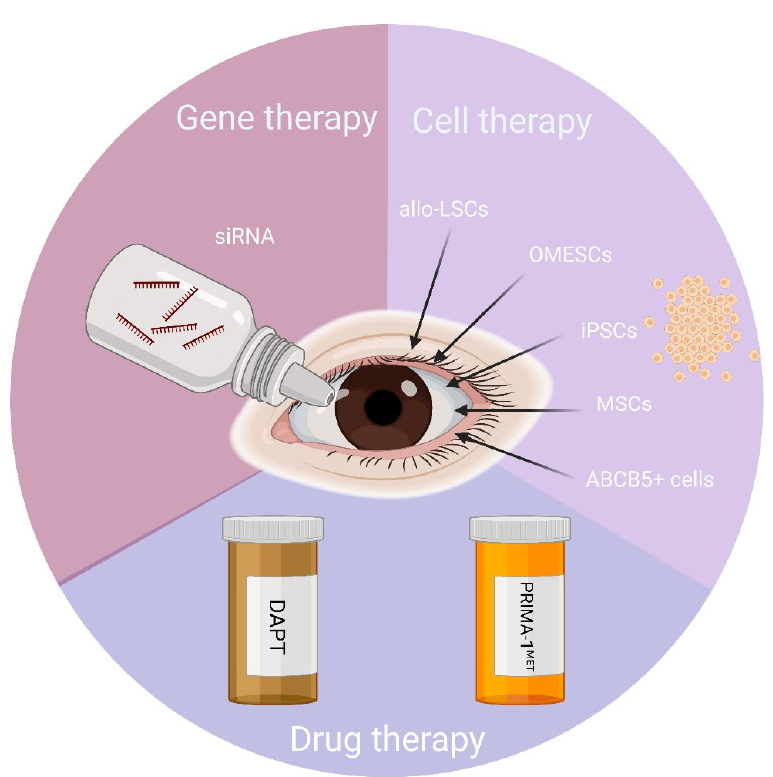
Figure 3. Approaches for the management of ocular defects in patients with EEC syndrome. There are a few therapeutic strategies that have been tested or are under progress for the treatment of the ocular defects in EEC syndrome: (i) gene therapy-based approaches by means of Allele-Specific (AS) siRNAs to correct the p63 mutations; (ii) cell therapy-based approaches to replenish the pool of limbal stem cells; and (iii) drug therapy to correct/bypass the genetic defect. Abbreviations: allo-LSCs: allogeneic Limbal Stem Cells; OMESCs: oral mucosa epithelial stem cells; iPSCs: Induced Pluripotent Stem Cells; MSCs: Mesenchymal Stem Cells; ABCB5: ATP Binding Cassette Subfamily B Member 5; DAPT: (N-[N-(3, 5-Difluorophenacetyl)-L-Alanyl]-S-Phenylglycine T-butyl ester); PRIMA-1MET: p53 reactivation and induction of massive apoptosis. Created with